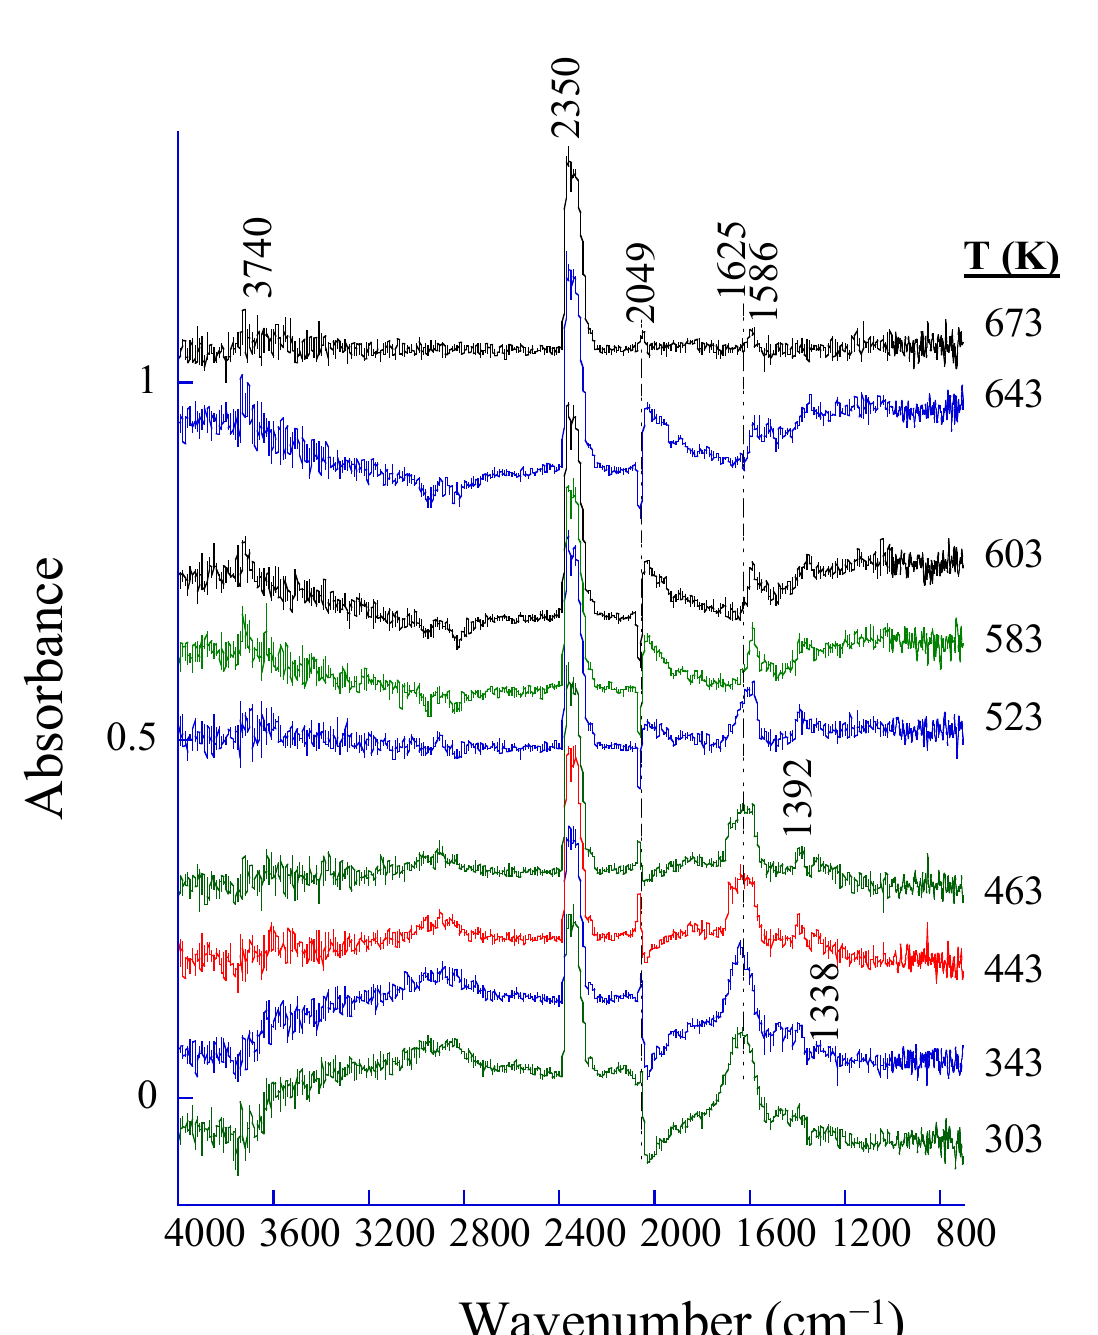
Figure 7- IR spectra during the exposure of the Rh/Al 2 O 3 catalyst to CO 2 flow at different temperatures.